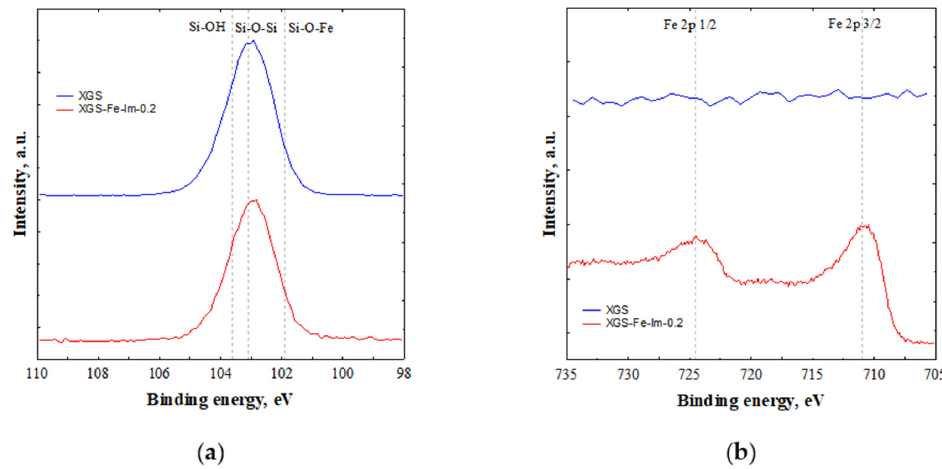
Figure 3. High-resolution XPS spectra for XGS and XGS-Fe-Im-0.2 ( a ) Si 2p; and ( b ) Fe